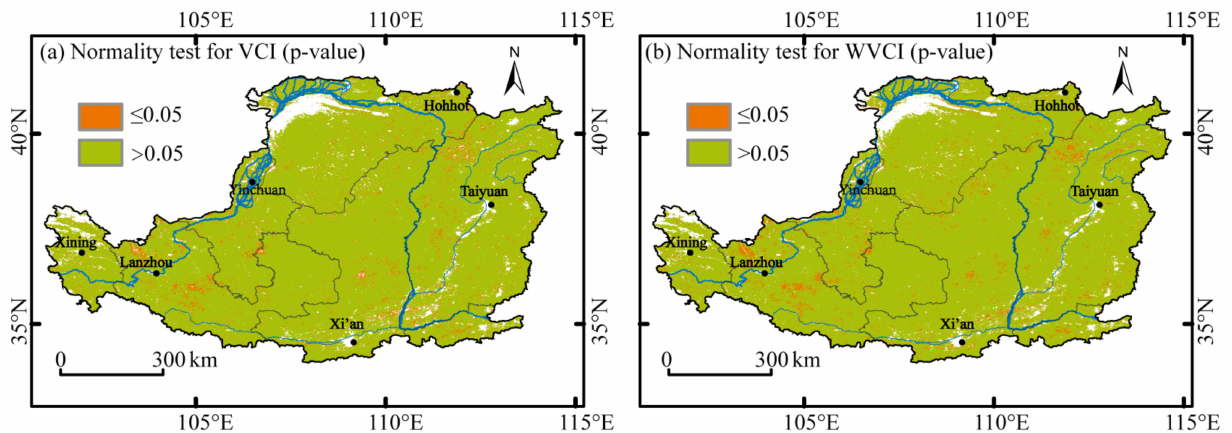
Figure A2. p -values of the Shapiro–Wilk test for normality of ( a ) VCI and ( b ) WVCI separately. If the p -value > 0.05, it denotes that the Shapiro–Wilk test does not show evidence of non-normality. Otherwise, the Shapiro–Wilk test indicates that the distribution of time series departs from